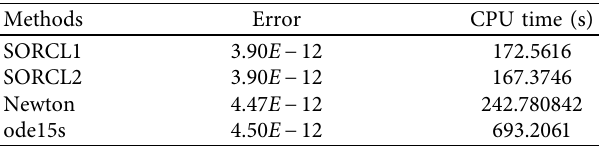
Table 9: Tolerance level at 10 − 12 (SIR model).